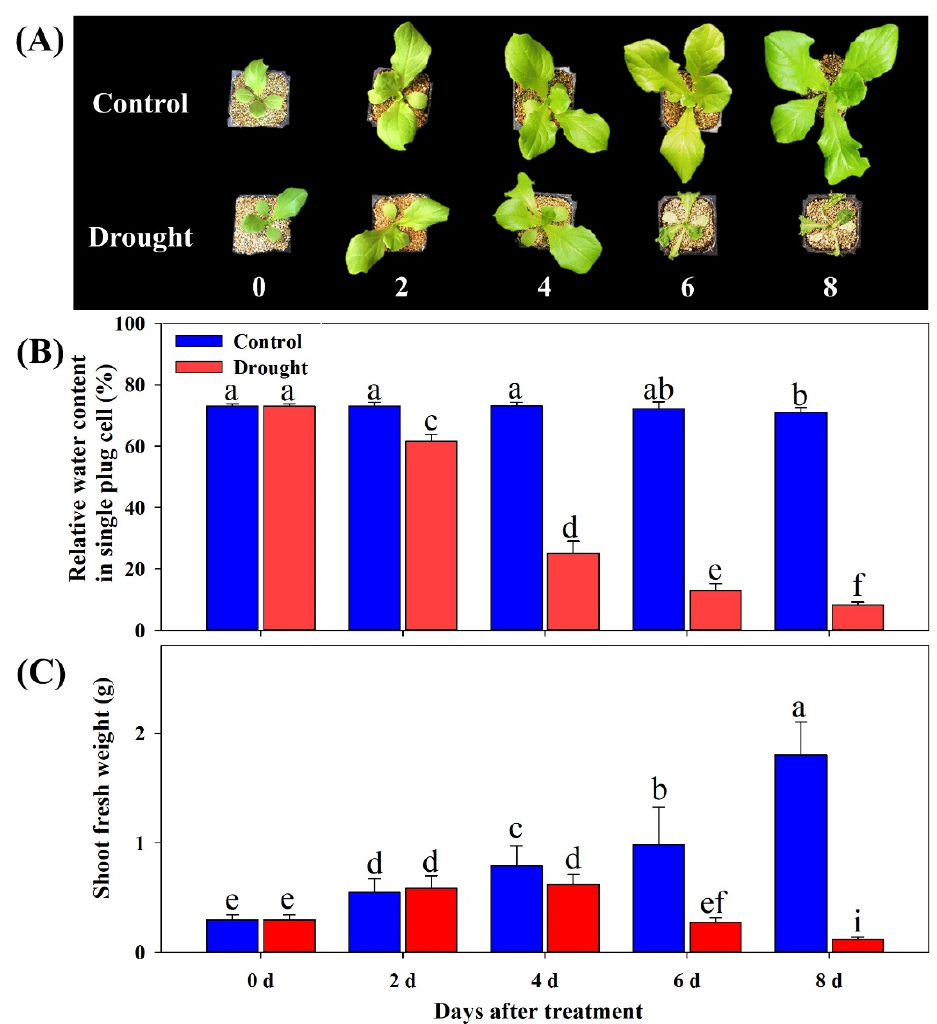
Figure 1. Changes in visual appearance of lettuce seedlings ( A ), relative water content in single plug cell ( B ), and shoot fresh weight ( C ) grown under control and drought stress conditions during progressive treatment time. Different letters indicate a significant difference at p < 0.05 by Duncan’s multiple range test.